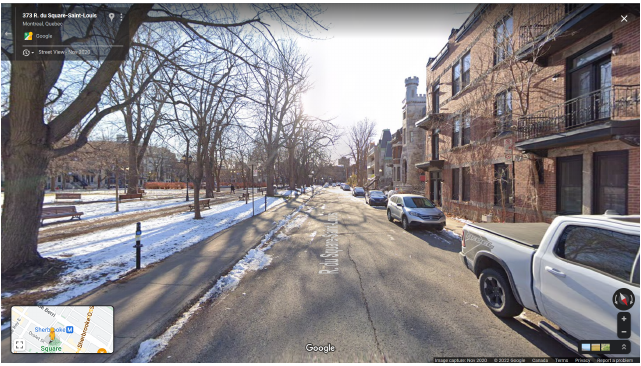
Figure 1. Google Street View image for a road in Montreal in